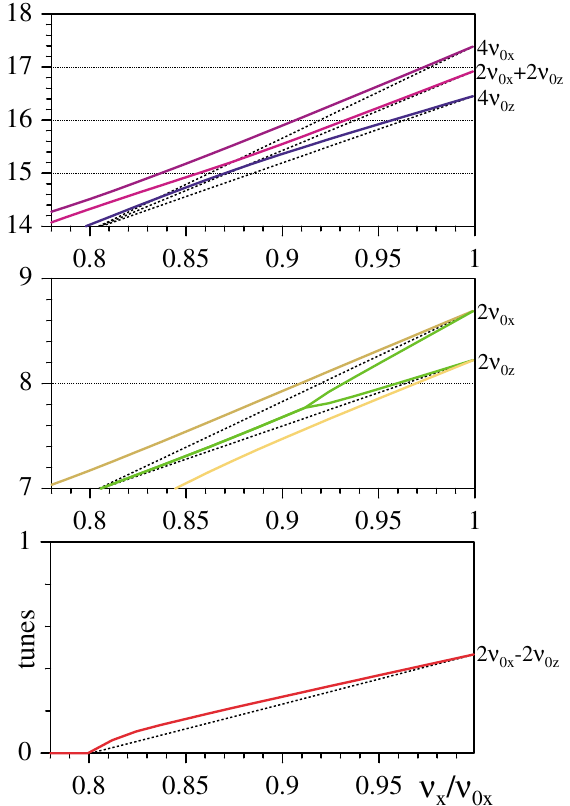
FIG. 2. (Color) Analytic results for fourth order even mode (cid:3) 2 and machine tunes (cid:10) =(cid:19) frequencies with (cid:19) z x (cid:3) 4 : 35 4 : 115 ; (cid:10) 0 x